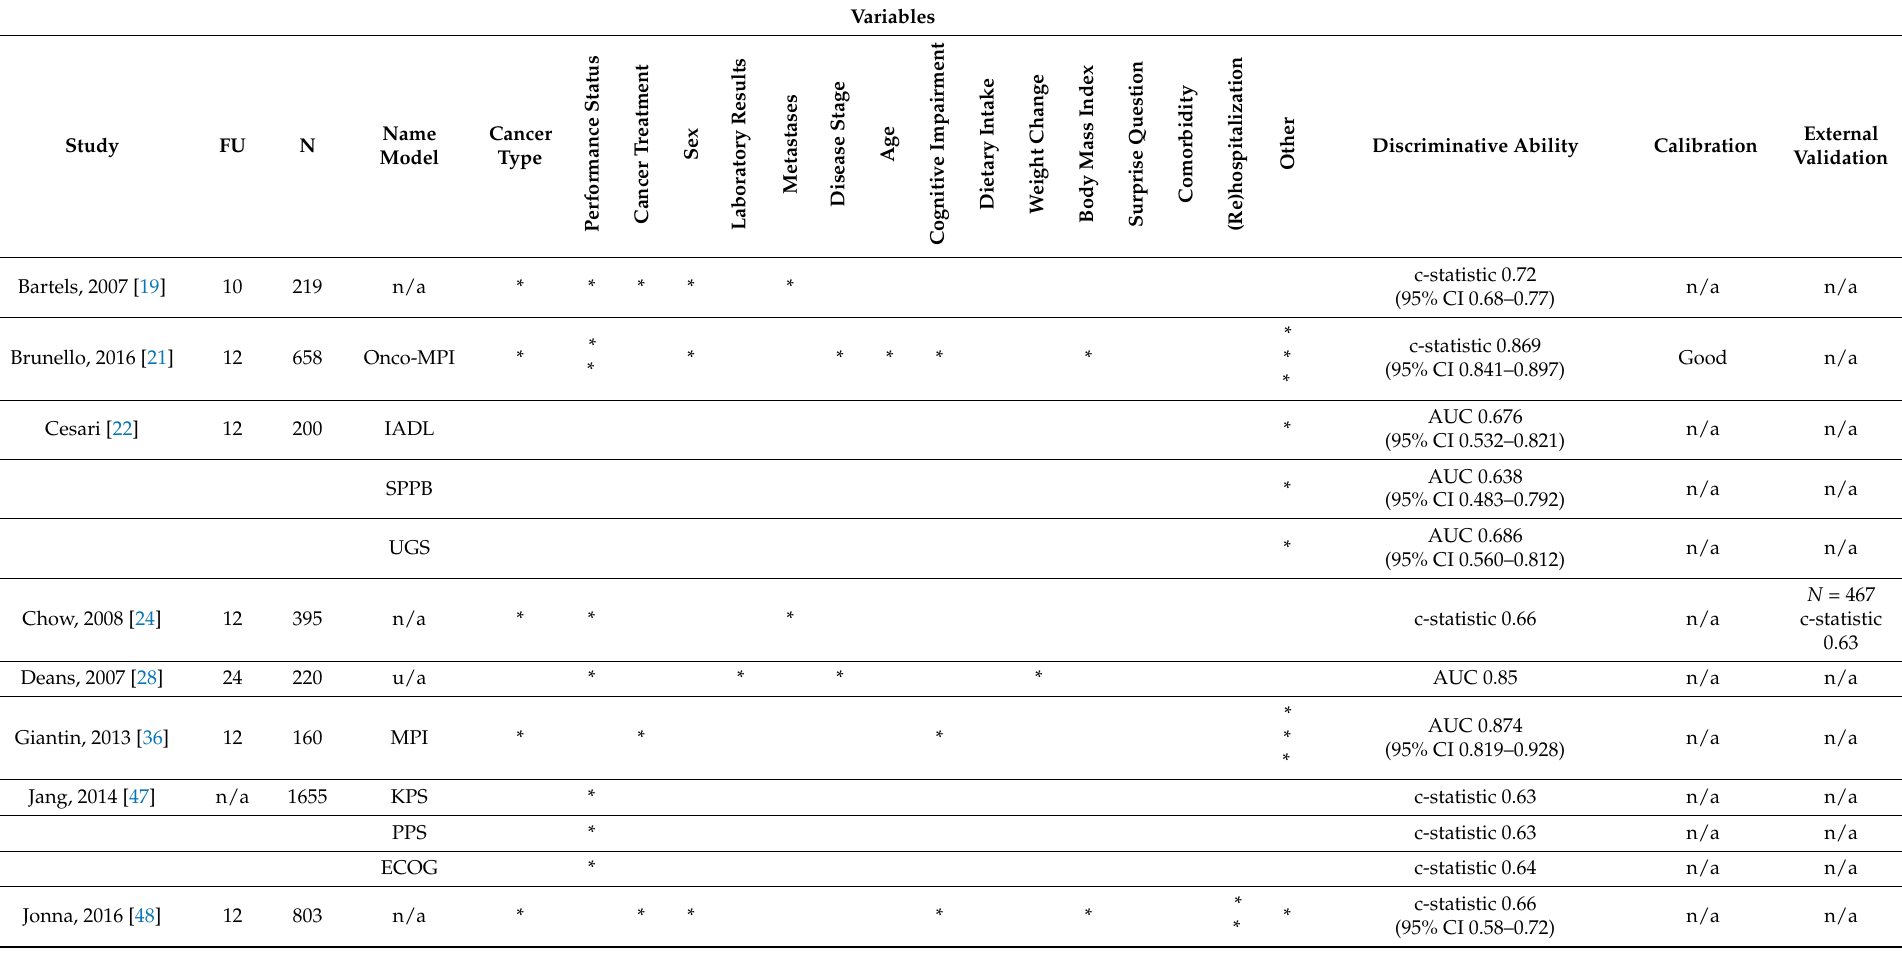
Table 3. Summary of the prediction